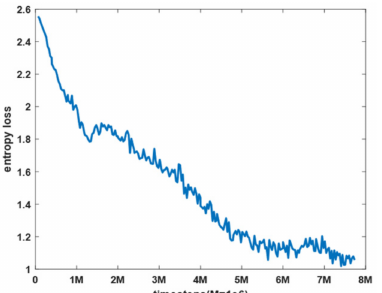
Figure 15. Entropy loss of the PPO algorithm in the training process.